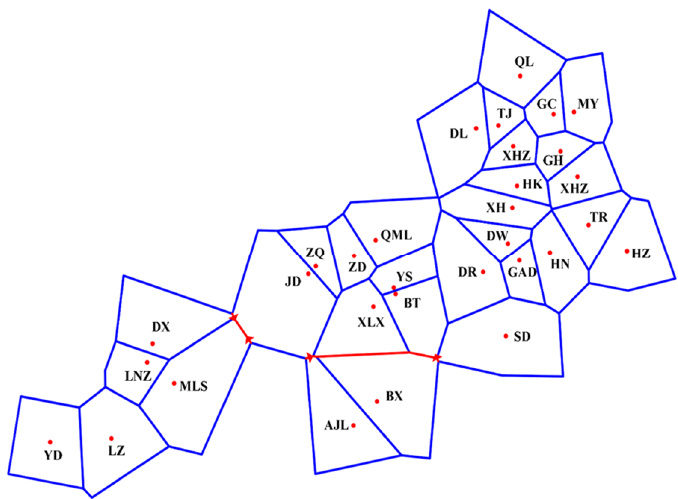
Figure 4. Genetic break among L. tibetica populations detected by BARRIER ( Numbers of barriers = 2 ).